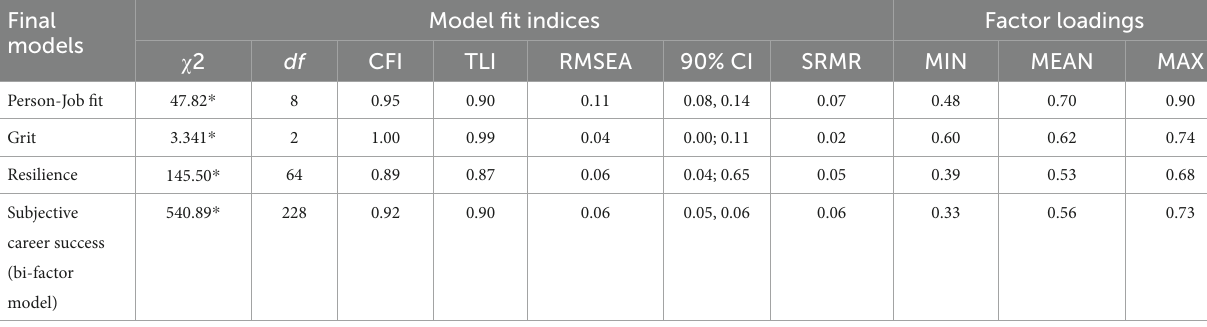
TABLE 2 Fit statistics per measurement model. Final